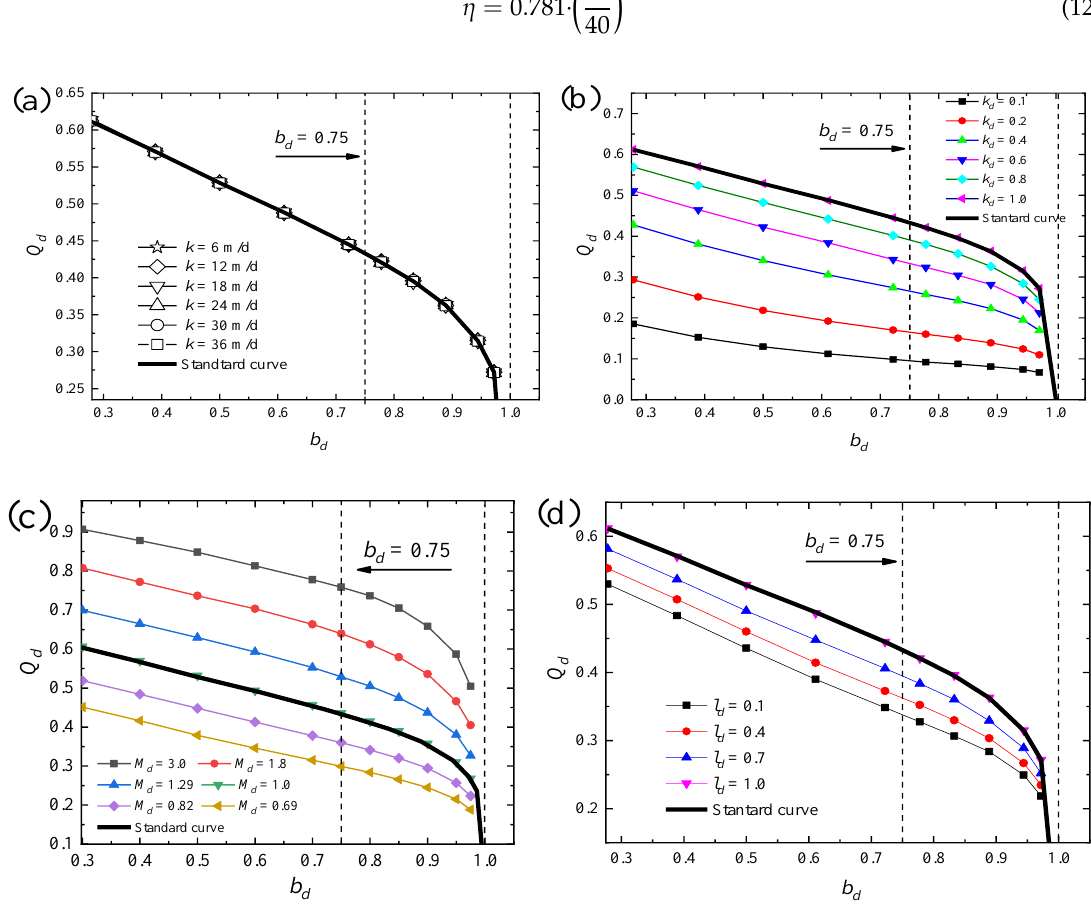
Figure 8. Variation curve of Q d – b d with varying dewatering parameters: ( a ) Permeability coefficient; ( b ) permeability anisotropy coefficient; ( c ) non-standard thickness coefficient; ( d ) well screen insertion ratio.